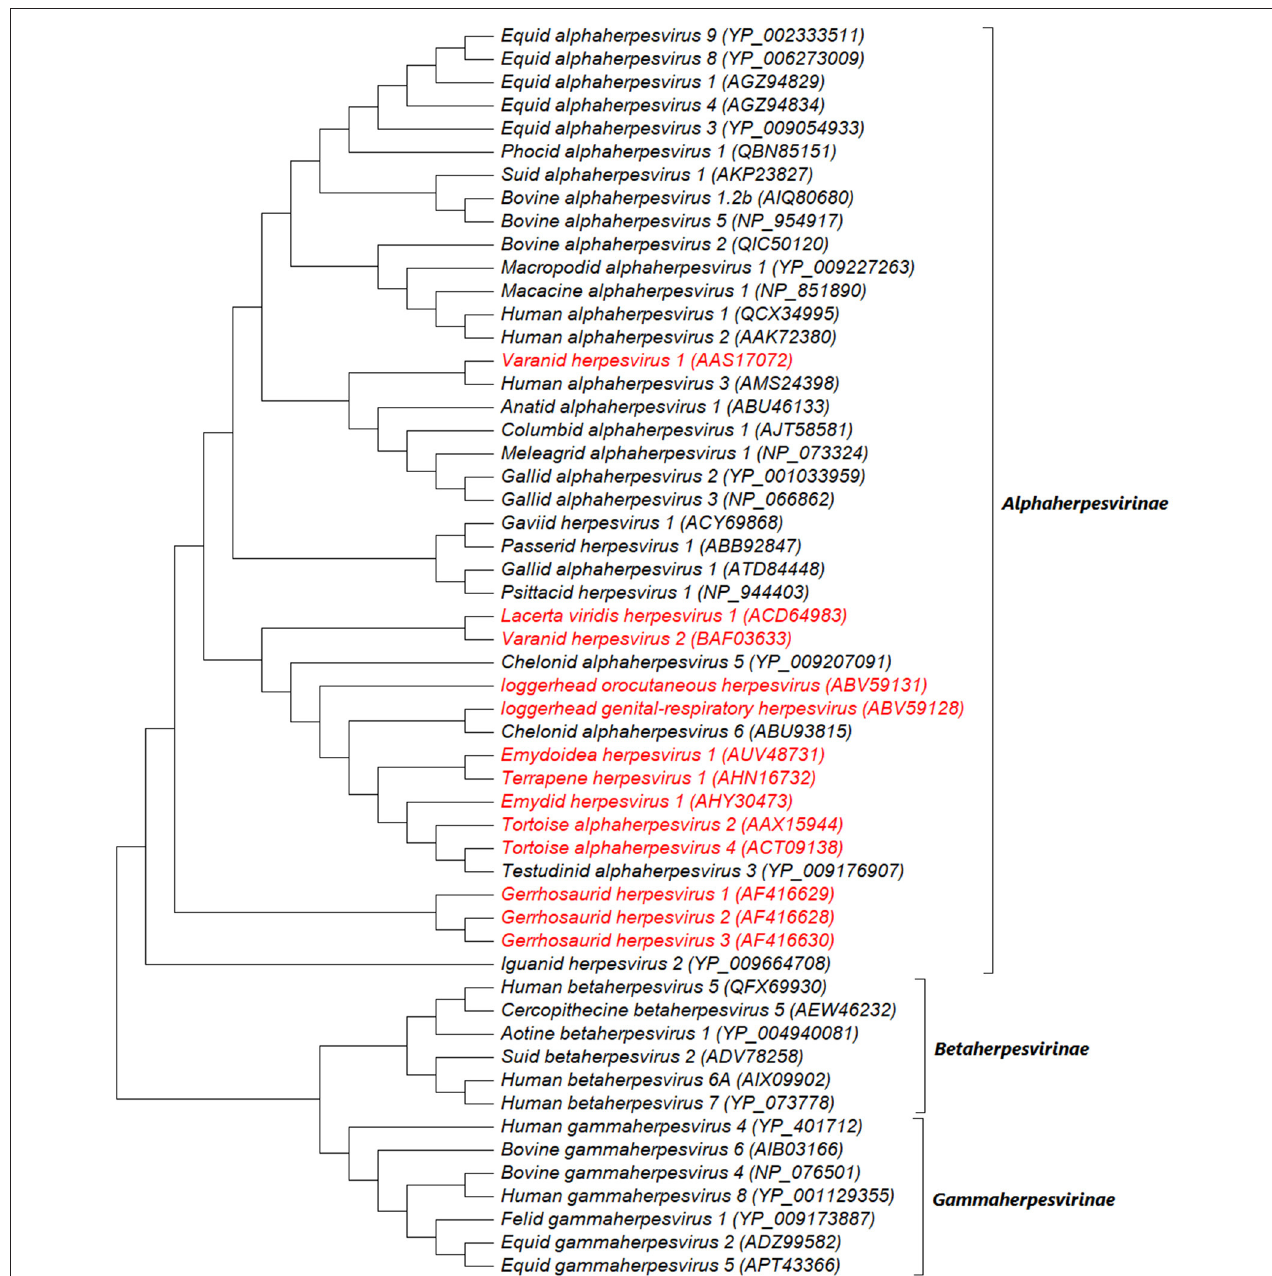
FIGURE 5 | Midpoint rooted maximum likelihood phylogenetic tree of predicted amino acid sequences of HV-DNA-dependent DNA polymerase. The unassigned reptilian HVs are shown in red and cluster within the subfamily Alphaherpesvirinae . This analysis involved 54 amino acid sequences (37 complete and 17 partial sequences) downloaded from NCBI website (https://www.ncbi.nlm.nih.gov/) and aligned by ClustalW. There were a total of 1,443 positions in the final dataset. The evolutionary history was inferred by using the Maximum Likelihood method and JTT matrix-based model. The tree with the highest log likelihood ( − 60139.09) is shown. Initial tree(s) for the heuristic search were obtained automatically by applying Neighbor-Join and BioNJ algorithms to a matrix of pairwise distances estimated using a JTT model, and then selecting the topology with superior log likelihood value. The tree is drawn to scale, with branch lengths measured in the number of substitutions per site. Evolutionary analyses were conducted in MEGA X